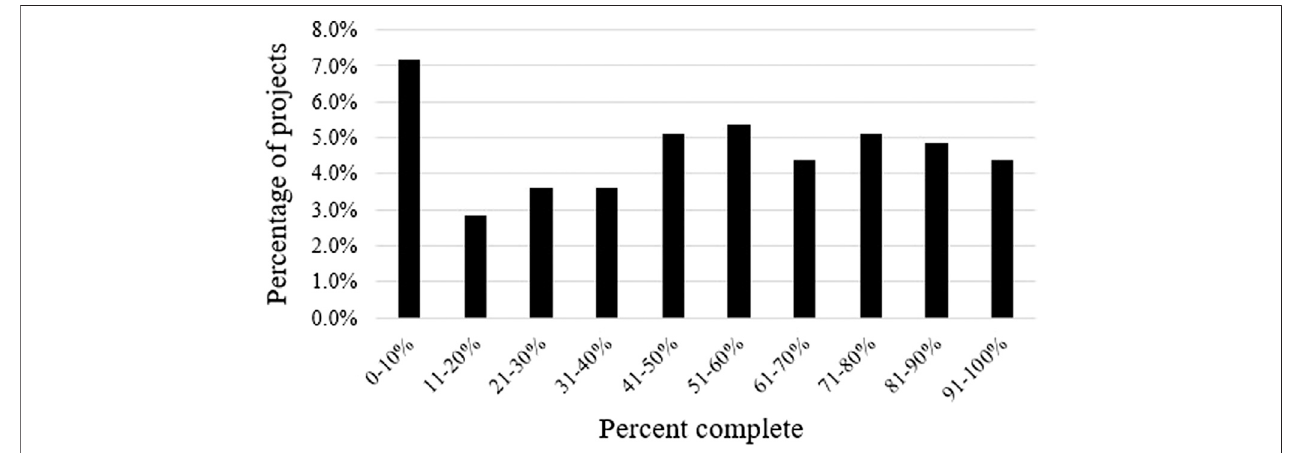
FIGURE 3 | Completion status for projects under construction.